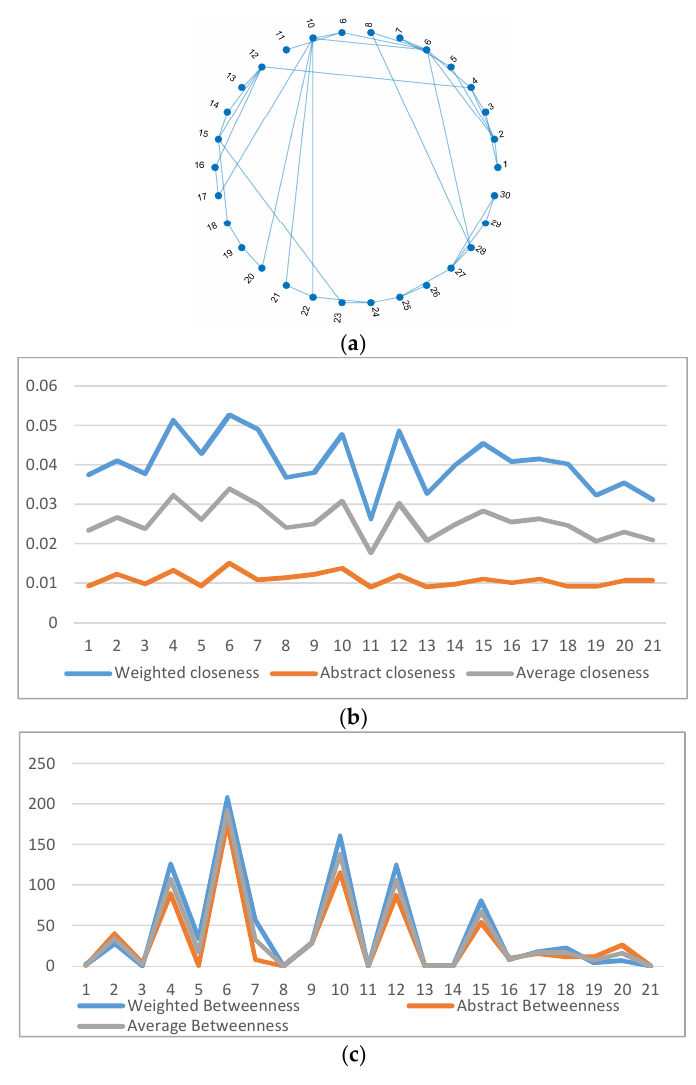
Figure 3. Shows the IEEE 30 bus network: ( a ) graph; ( b ) Closeness centrality; ( c ) Betweenness centrality. The clustering measure is an index that evaluates which vertices in a graph will cluster